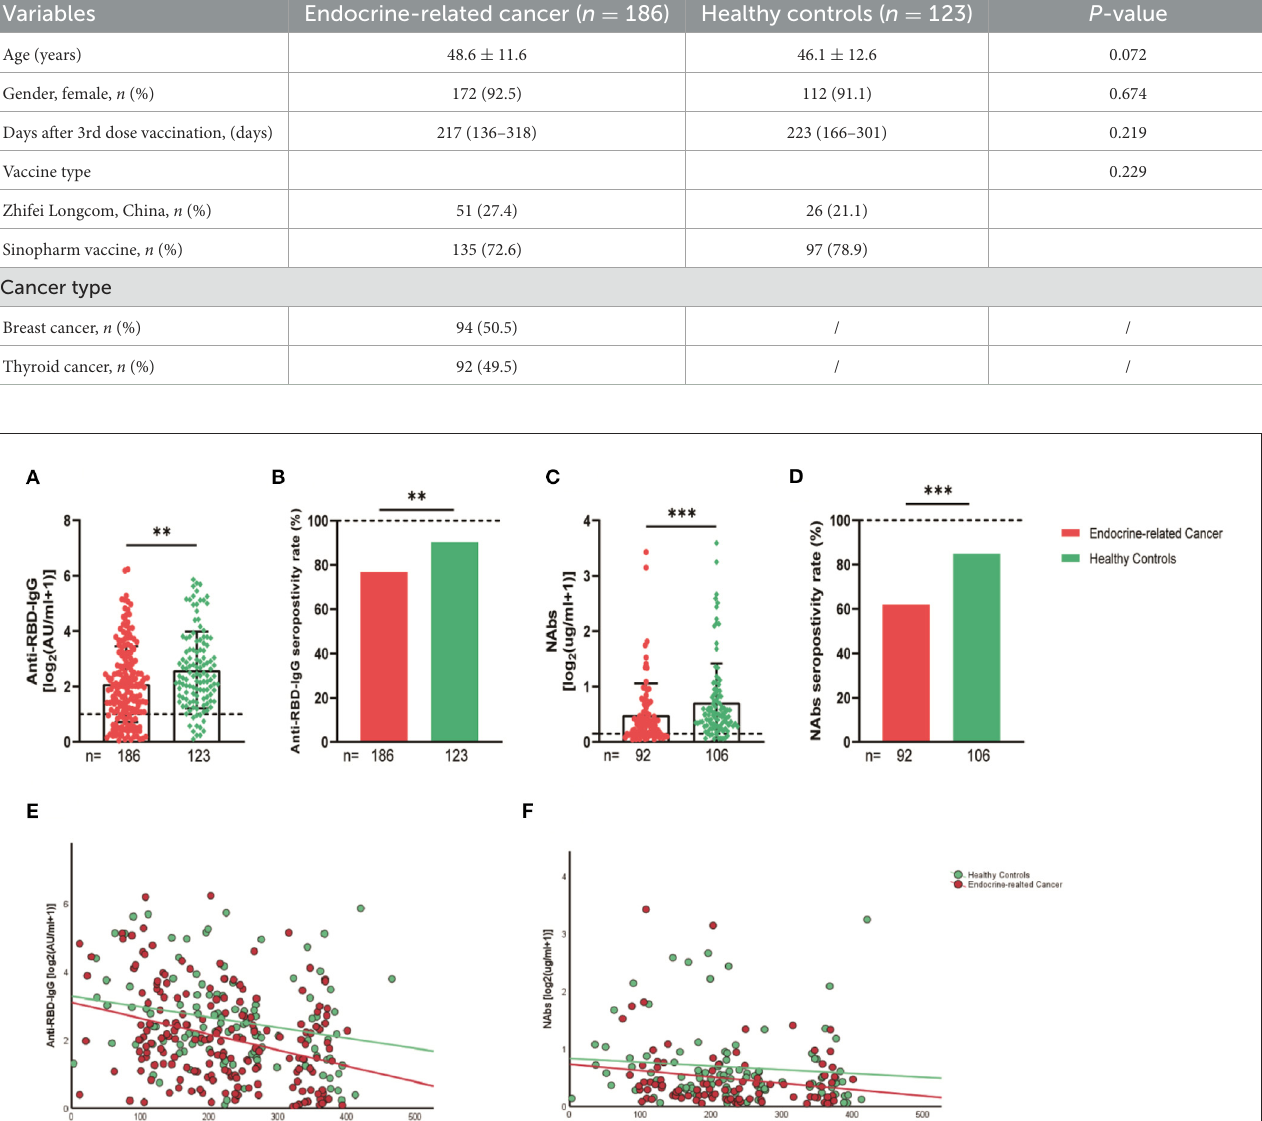
controls irrespective of gender or vaccine type (Figures 4, 5),